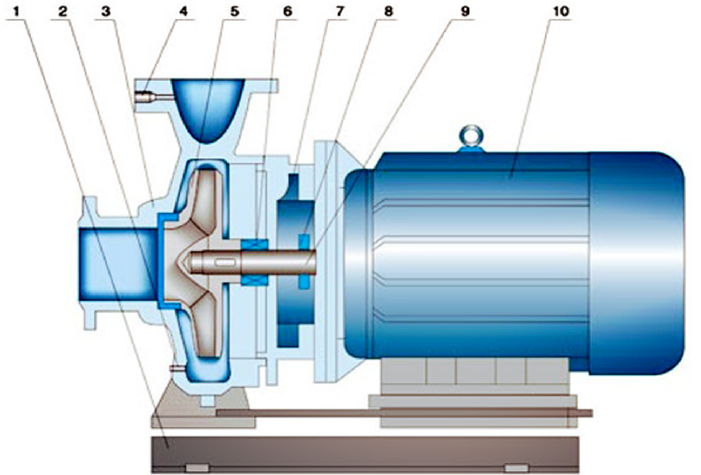
Figure 1. Typical structure diagram of the centrifugal pump unit. 1. Base. 2. Waterproof port. 3. Pump body. 4. Pressure tap. 5. Impeller. 6. Bearing. 7. Support frame. 8. Water retaining ring. 9. Pump shaft. 10.